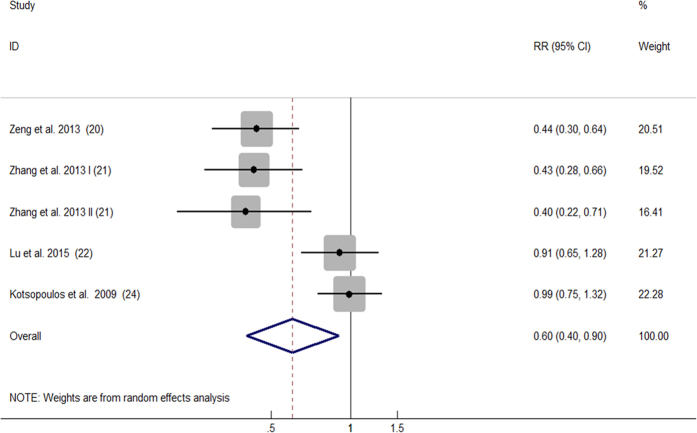
Forest plot of highest versus lowest categories of choline plus betaine consumption on cancer risk.RR, relative risk; CI, confidence interval; I, stage one; II stage two.